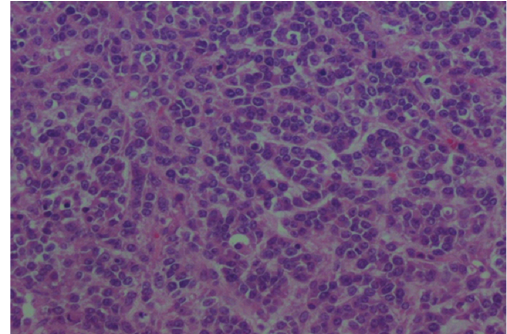
Figure 2: Monomorphic round cells with many mitoses ( × 200).